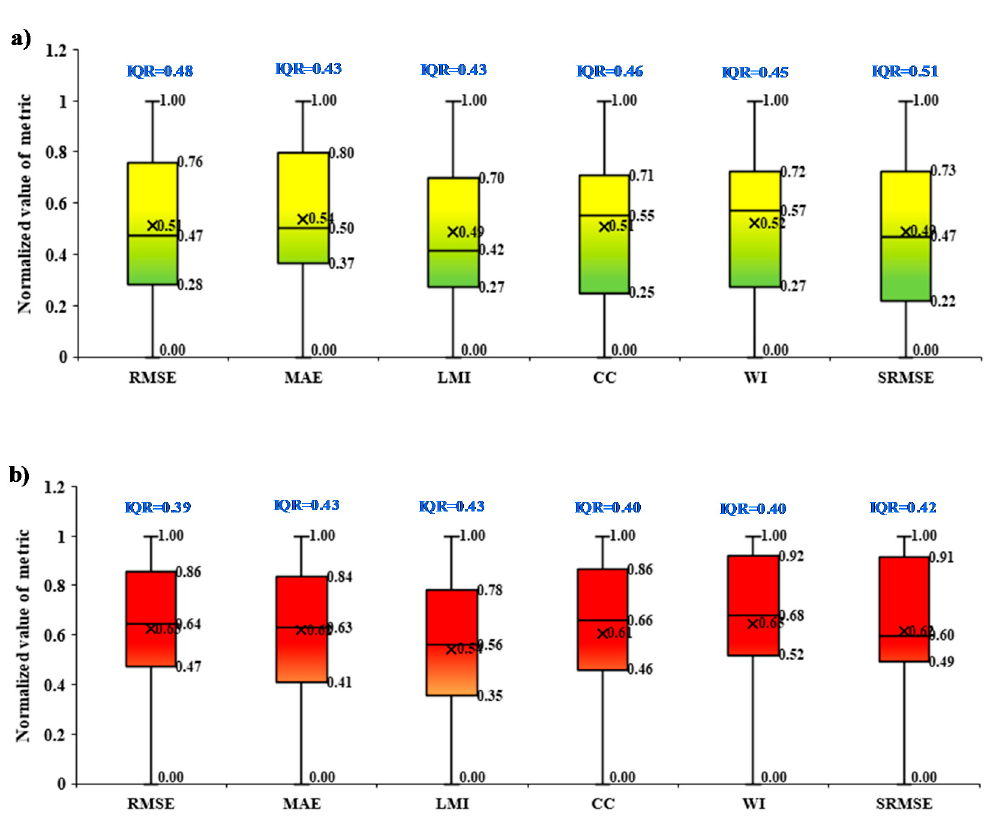
Figure 10. Boxplot of data’s uncertainty based on indices over ( a ) Training stage and ( b ) Testing stage.